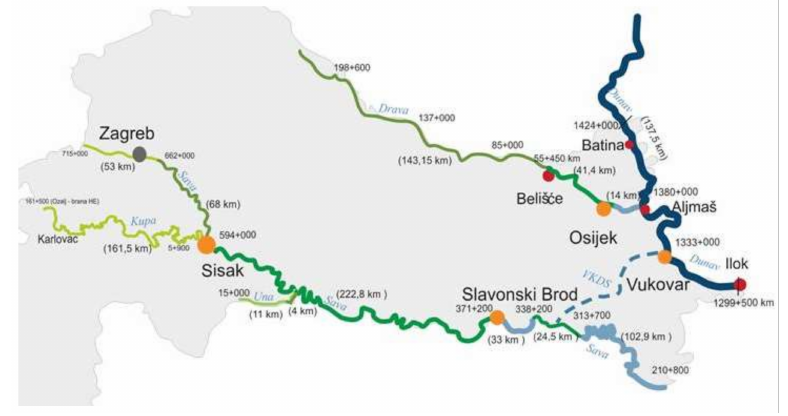
Figure 7. Inland waterway network of Croatia [62].